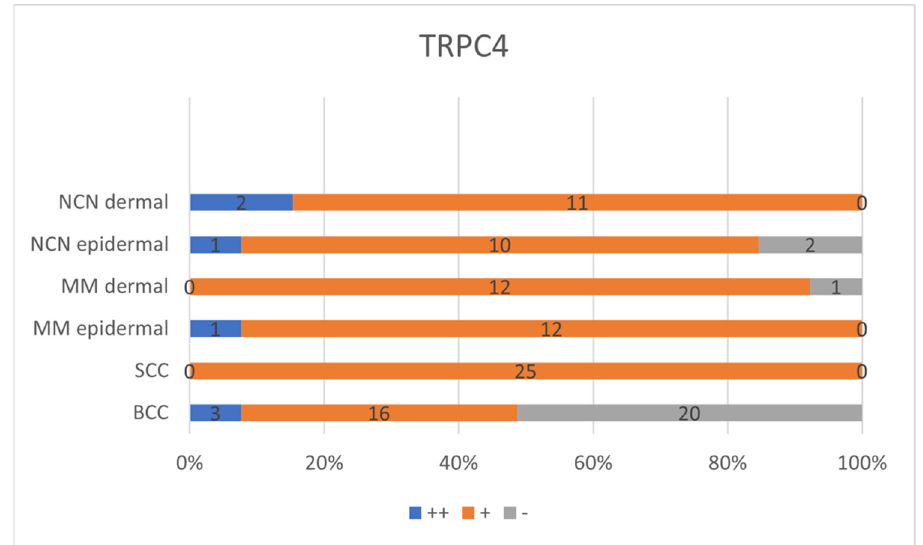
Figure 3. Summary of immunohistochemical scoring results for TRCP4 on NCN, MMs, SCCs and BCCs. ++/blue bar: strongly positive staining with >80% of cells positive and/or staining intensity is high; +/orange bar: 20–80% of cells show a weakly positive/partially positive reaction; − /grey bar: <20% of cells with weak staining (= negative reaction). NCN and MM are subdivided into epidermal and dermal portions. Numbers in bars represent the occurrence of the particular score. For additional information on the individual scores, see Supplementary Tables S1–S5.